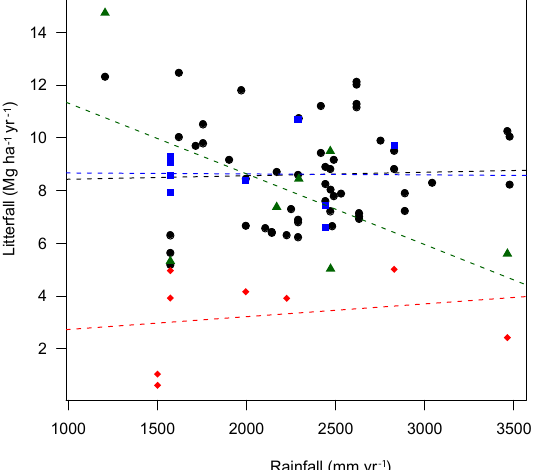
Fig. 5. Total annual litterfall on different soil types. Soil types are based on the WRB taxonomy (for more details, see Methods and Quesada, 2008). Soil types are as follows. A: arenosols/podzols; B: ferrasols; C: acrisols/plinthosols/alisols); D: cambisols/leptosols/histosols/gleysols/fluvisols. The notations of this figure are the same as in Fig.